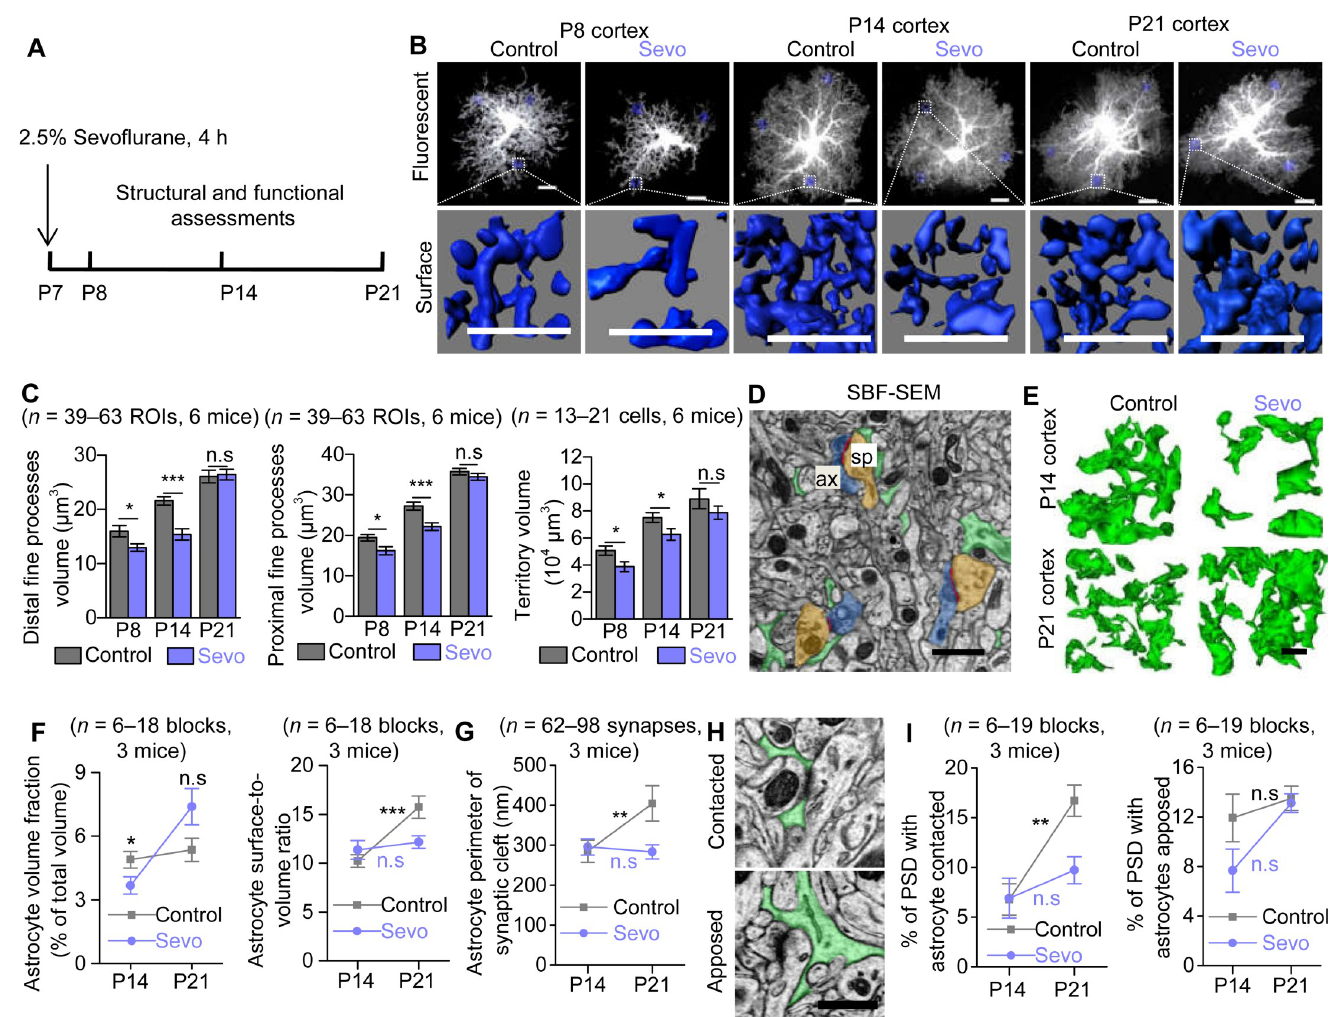
Fig 1. Lengthy Sevo exposure disrupted astrocyte morphogenesis and compromised “tripartite synapse” maturation in developing somatosensory cortex. ( A ) Schematic illustrating the experimental protocol for Sevo exposure. ( B ) Representative confocal images and 3D reconstructed distal fine processes of sparsely labeled astrocytes from Control and Sevo group mice at P8, P14, and P21. Scale bars, 10 μ m. ( C ) Quantification of astrocyte distal fine processes volume ( Left ) (P8: P = 0.02; P14: P < 0.001; P21: P = 0.82; unpaired t test), proximal fine processes volume ( Middle ) (P8: P = 0.012; P14: P < 0.001; P21: P = 0.279; unpaired t test), and territory volume ( Right ) (P8: P = 0.028; P14: P = 0.03; P21: P = 0.248; unpaired t test) in Control and Sevo mice. ( D ) SBF-SEM images of astrocyte fine processes (green), PSD (red), axonal bouton (ax, blue), and dendritic spine (sp, brown). Scale bar, 1 μ m. ( E ) Three-dimensional reconstruction of astrocyte fine processes in Control and Sevo group mice at P14 and P21. Scale bar, 1 μ m. ( F ) Left , comparison of astrocyte volume fraction in Control and Sevo group mice (P14: P = 0.038; P21: P = 0.074; unpaired t test). Right , increased astrocyte surface-to-volume ratio from P14 to P21 in Control ( P < 0.001, unpaired t test) group mice but not in Sevo group mice ( P = 0.628, unpaired t test). ( G ) Increased astrocyte perimeter enwrapping the synaptic cleft from P14 to P21 in Control ( P = 0.007, Mann-Whitney test) group mice but not in Sevo group mice ( P = 0.232, Mann-Whitney test). ( H ) SBF-SEM images of astrocytes contacted or apposed PSD. Scale bar, 0.5 μ m. ( I ) Left , increased PSD with astrocytes contacted from P14 to P21 in Control group mice ( P = 0.002, Mann-Whitney test) but not in Sevo group mice ( P = 0.129, Mann-Whitney test). Right , unchanged PSD with astrocytes apposed from P14 to P21 in Control ( P = 0.105, Mann-Whitney test) and Sevo ( P = 0.07, unpaired t test) groups. � P < 0.05; �� P < 0.01; ��� P < 0.001; n.s, not significant. Data are shown as mean ± SEM. Underlying data are available in S1 Data. n.s, not significant; PSD, postsynaptic density; SBF-SEM, serial block face scanning electron microscopy; Sevo, sevoflurane.